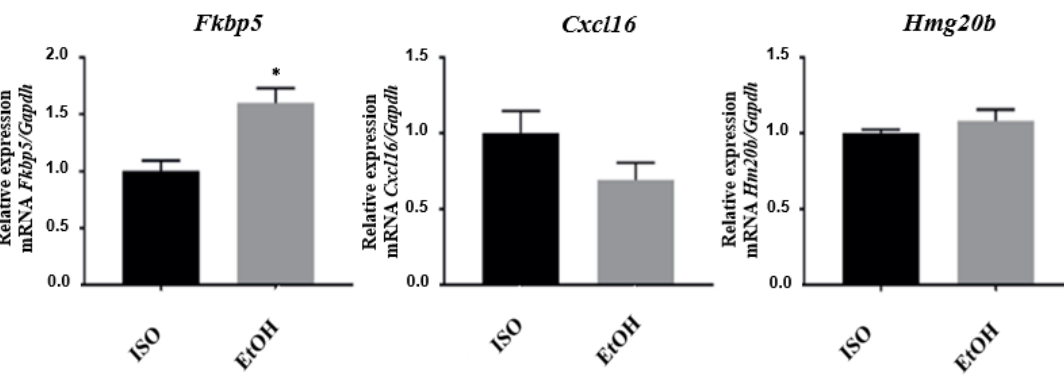
Figure 2. mRNA quantification and relative expression of genes altered by EtOH exposure in the prefrontal cortex. Fold change < 1 indicates reduced expression in response to ethanol relative to a value of 1.* p < 0.05.